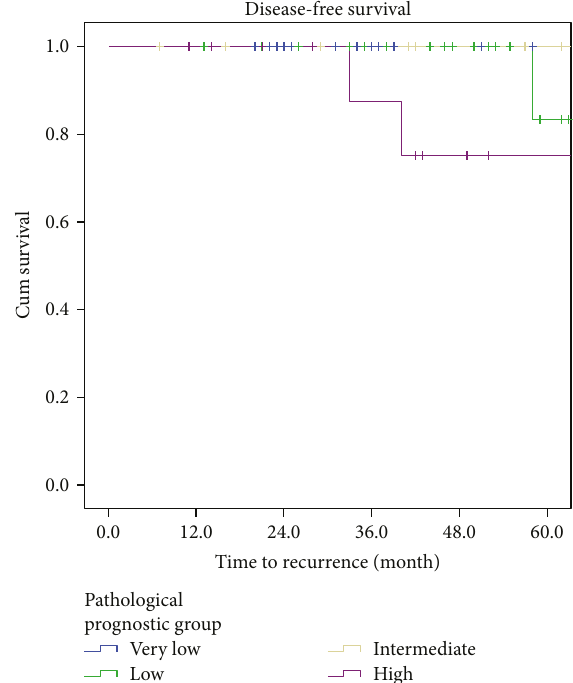
Figure 3: Survival according to the pathological prognostic group